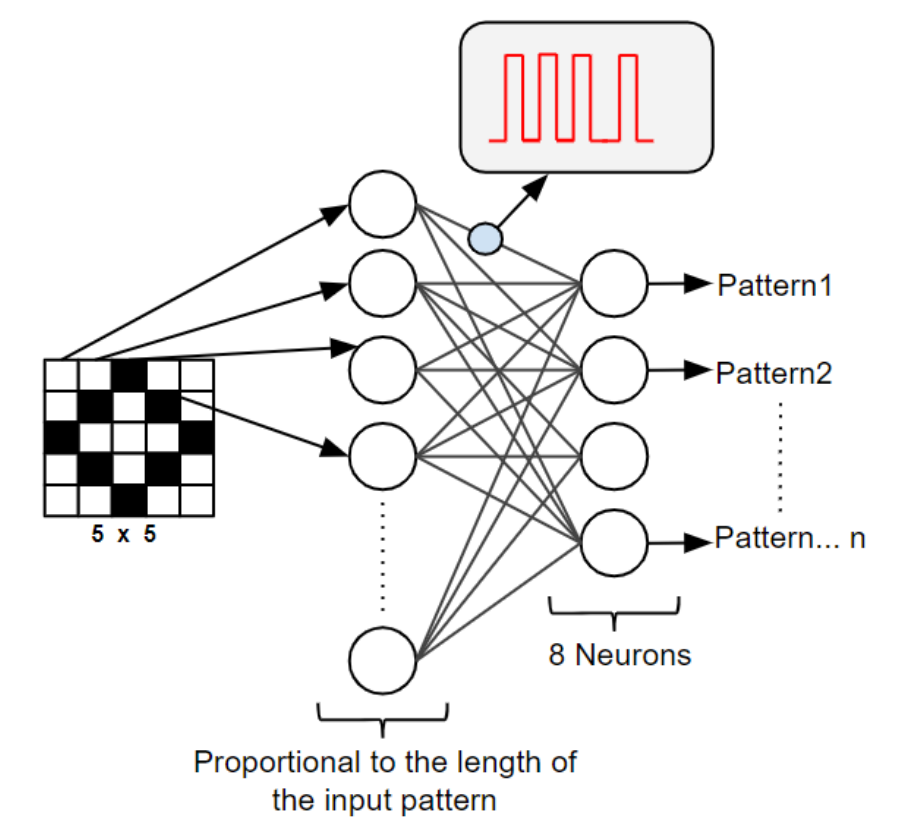
Figure 7. The architecture of the WTA neural network. A pattern is applied to the input layer that generates spikes. An output neuron corresponding to the input pattern is activated accordingly.